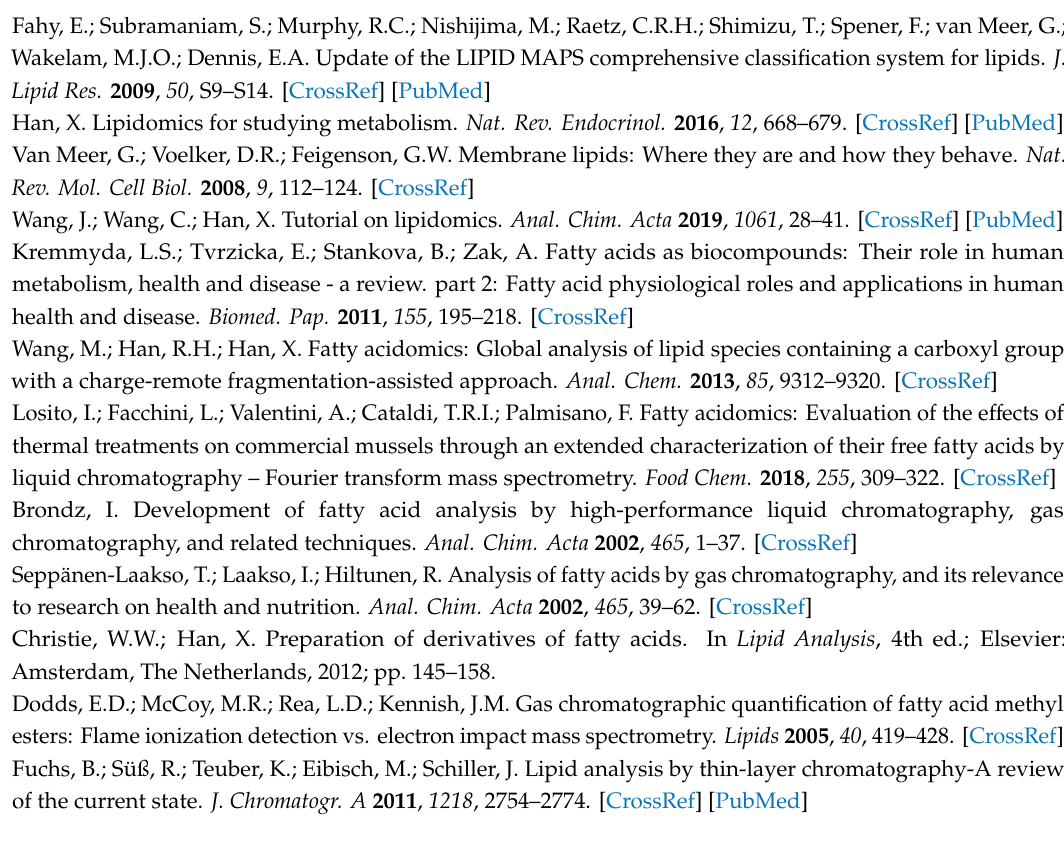
ion of PI at m / z 241.013. Figure S3. Extracted ion current chromatograms (XIC) obtained by HILIC-ESI-FTMS analysis of a plasma sample using AIF scan MS. XIC chromatograms were obtained using narrow windows centred on selected m / z values corresponding to those of the most intense carboxylate ions of each lipid class (see Table 2). Figure S4. AIF MS spectra averaged under the HILIC bands of PI (A), PE (B), PC (C) and LPC (D), as obtained upon HILIC-ESI( − )-FTMS analysis of a plasma lipid extract. Figure S5. XIC (A) and AIF scan (B) of FA C22:6 linked to PC 40:6 and PC 38:6. Note that the source induced fragmentation (sid) at an energy of 40 eV was applied in both cases. Figure S6. Superimposition of XIC traces referred to PI 38:3 and FA C20:3, obtained using full MS and AIF MS acquisition modes, respectively, during the HILIC-ESI( − )-FTMS analysis of a lipid extract of human dermal